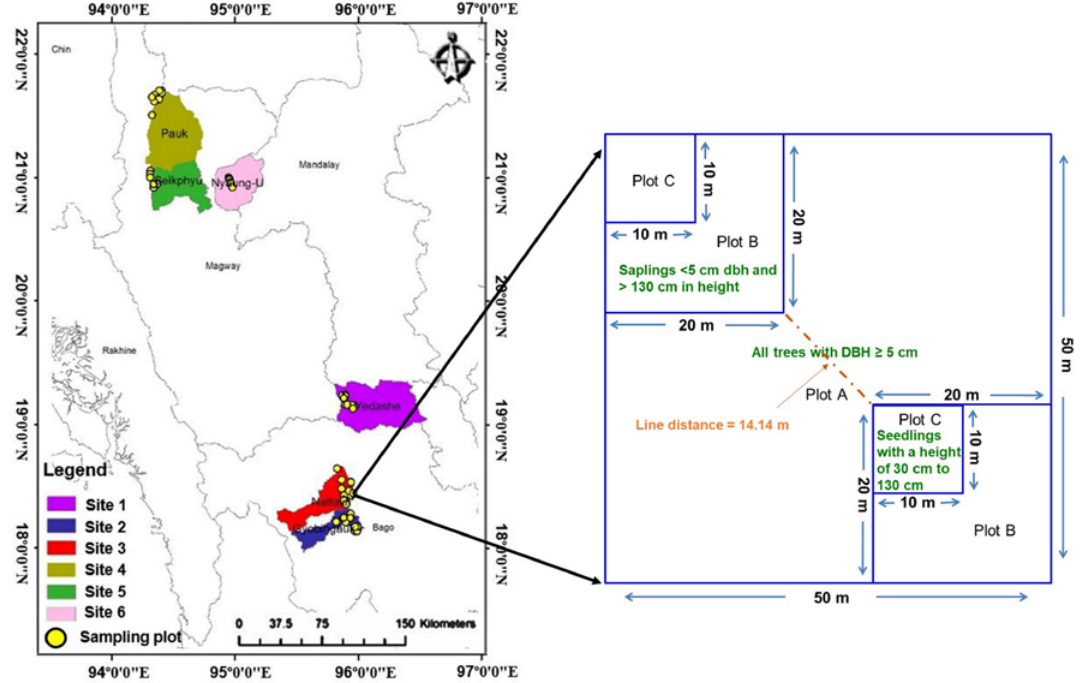
Figure 1. Location map of the study areas, and layout of sampling plots. Table 1. Climatic variables of the study